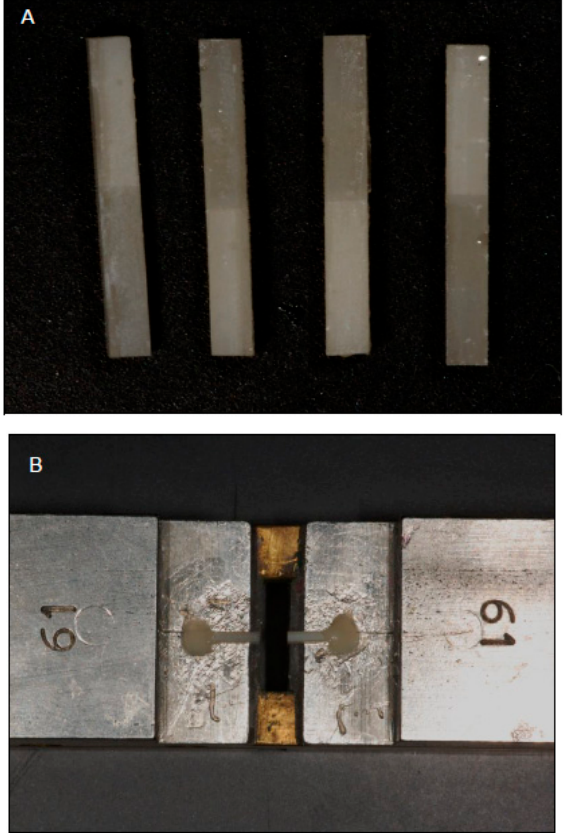
Figure 5. ( A ) Dentin bonded specimen sticks using experimental adhesives with 1 × 1 mm dimensions. ( B ) Debonded specimens after microtensile testing.